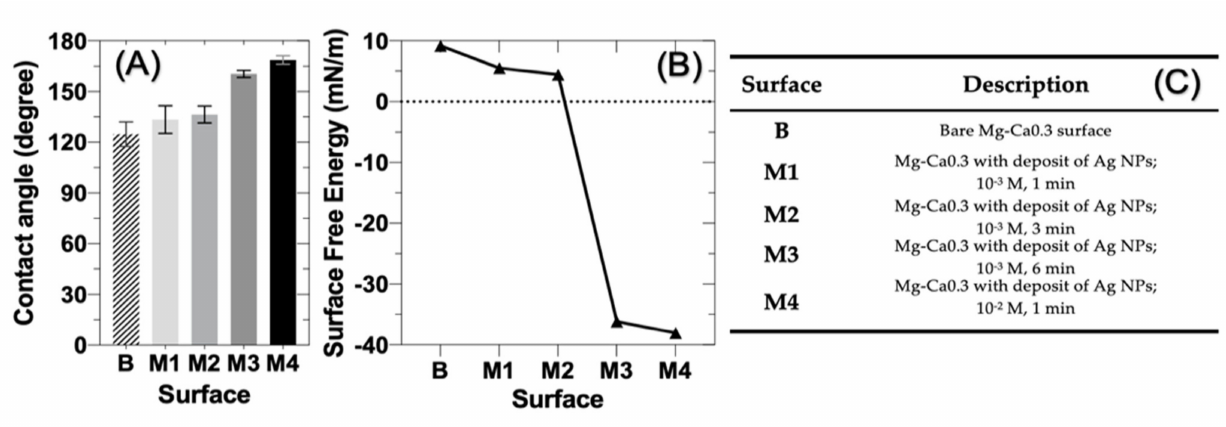
Figure 13. ( A ) Contact angle values, ( B ) calculated surface free energy (SFE), and ( C ) description of the